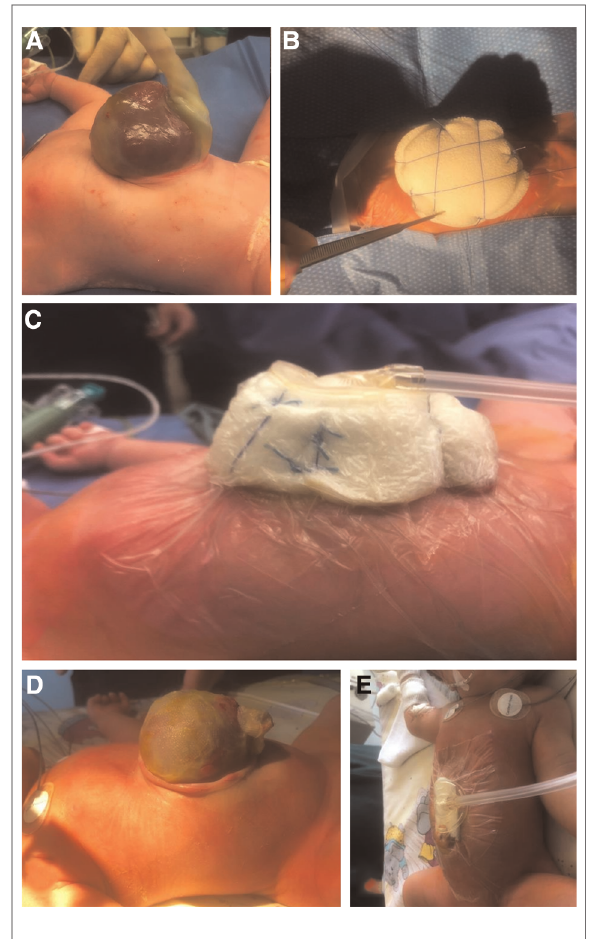
FIGURE 1 ( A ) Giant omphalocele with eviscerated bowel and liver. ( B ) Cutaneous sagittal and horizontal four-point- fi xation of foam cylinder. ( C ) Lateral view on attached VAC device. ( D ) Omphalocele after removal of VAC dressing. ( E ) Lateral view at VAC device after amnial plication maneuver and foam application just above the skin